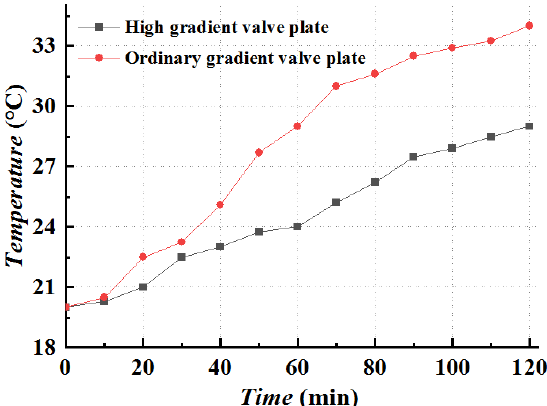
Figure 10. Temperature distribution of 120 min high-gradient and ordinary-gradient arrestor un- der power frequency voltage.